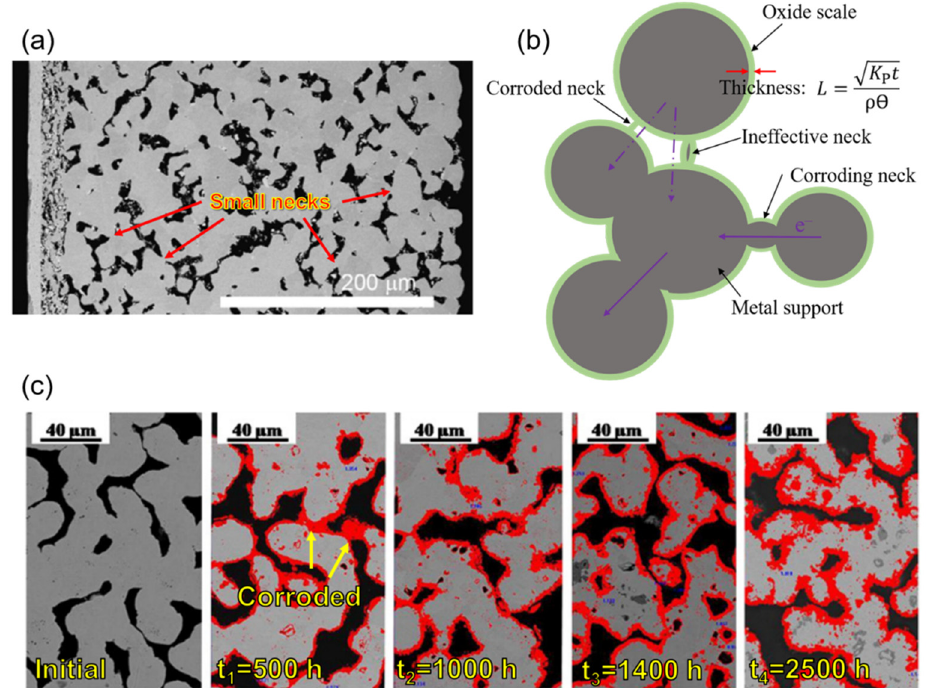
Figure 7. ( a ) SEM image showing the polished cross-section of the planar metal-supported half- cell. The electrolyte is shown at the top, followed by the cermet layer and the metal support, reproduced with permission from Ref [65]. ( b ) Schematic diagram of the loss of conductivity of the metal support due to oxidation adapted from Ref [9]. ( c ) Cross-sectional SEM images of the metal support with a grown outer oxide layer in darker grey at different exposure times at 800 °C